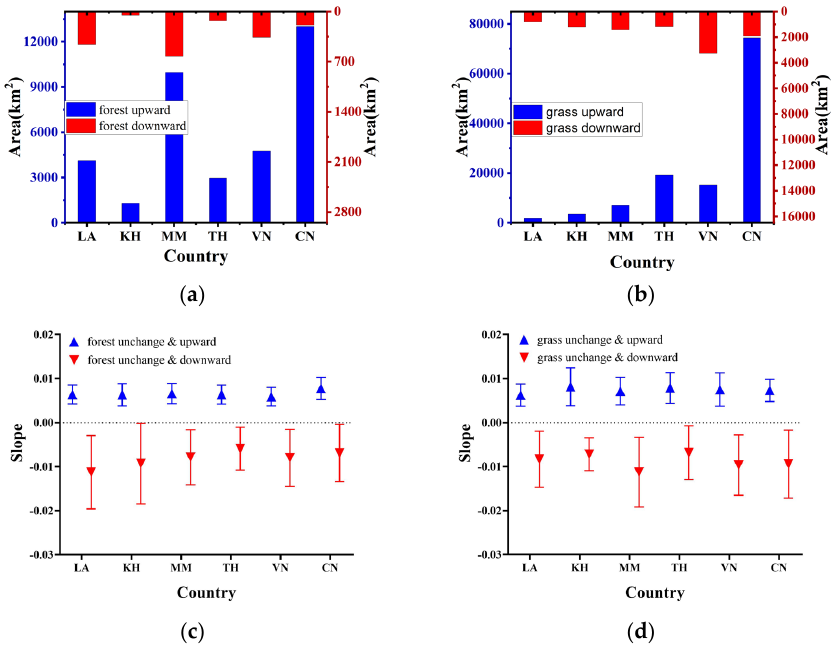
Figure 5. Area and slope distributions of significant EVI trends for forests and grasslands with no change type change: ( a ) area of EVI trends for forests; ( b ) area of EVI trends for grasslands; ( c ) slope of EVI trends for forests; ( d ) slope of EVI trends for grasslands.